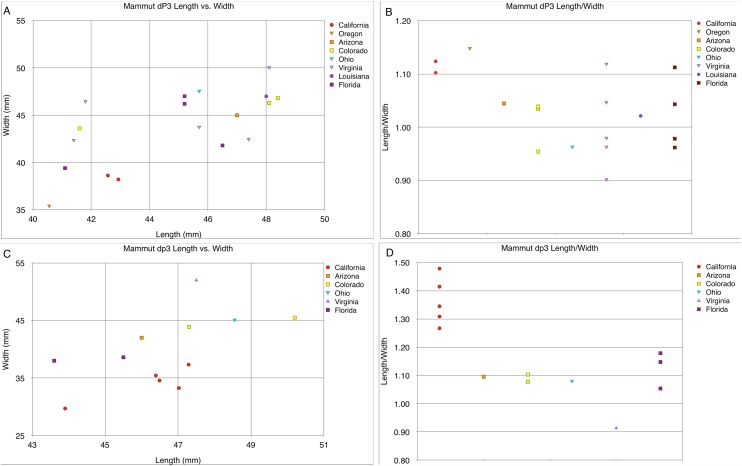
Length and width comparisons of Mammut dP3 and dP3, by state/province/country.(A) Length vs. width of Mammut dP3. M. pacificus is indicated in red, (B) length/width of Mammut dP3, organized by location. M. pacificus is indicated in red, (C) length vs. width of Mammut dP3. M. pacificus is indicated in red, and (D) length/width of Mammut dP3, organized by location. M. pacificus is indicated in red.